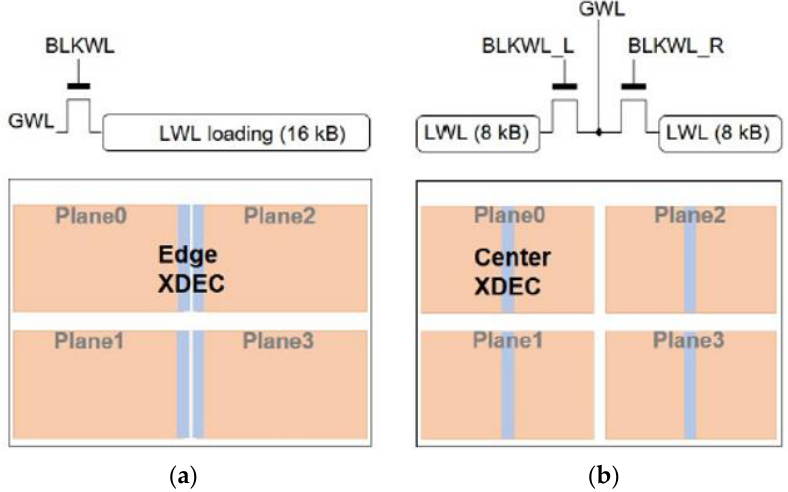
Figure 18. XDEC (WL driver) architecture. ( a ) XDEC is placed at the edge of the local WL. ( b ) XDEC is placed at the center of the local WL, reducing the LWL load to a half for faster operations. Reprinted with permission from ref. [31], Copyright 2021 IEEE.